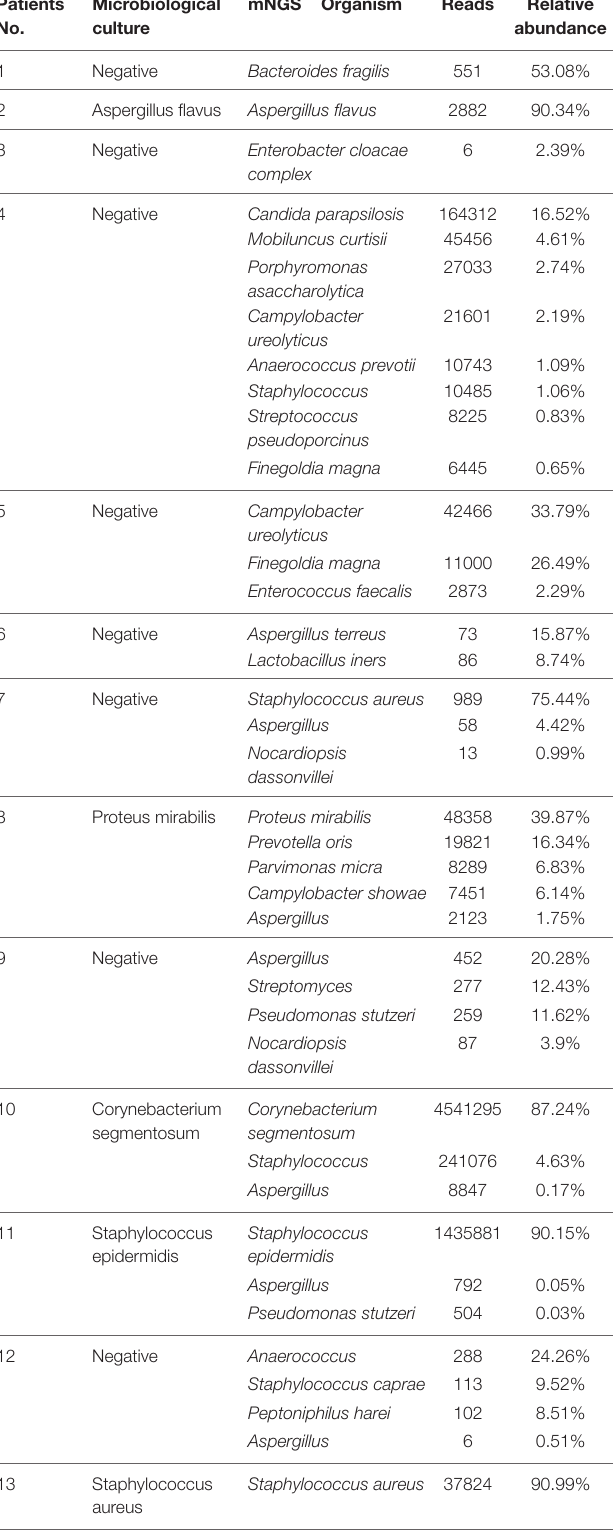
TABLE 3 | Microbiological culture results and mNGS results of 16 cholesteatoma